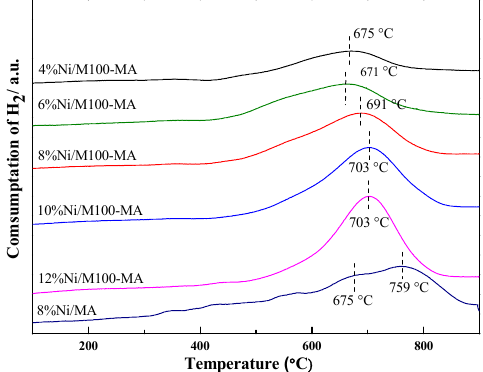
Figure 3. H 2 -TPR profiles of the samples.